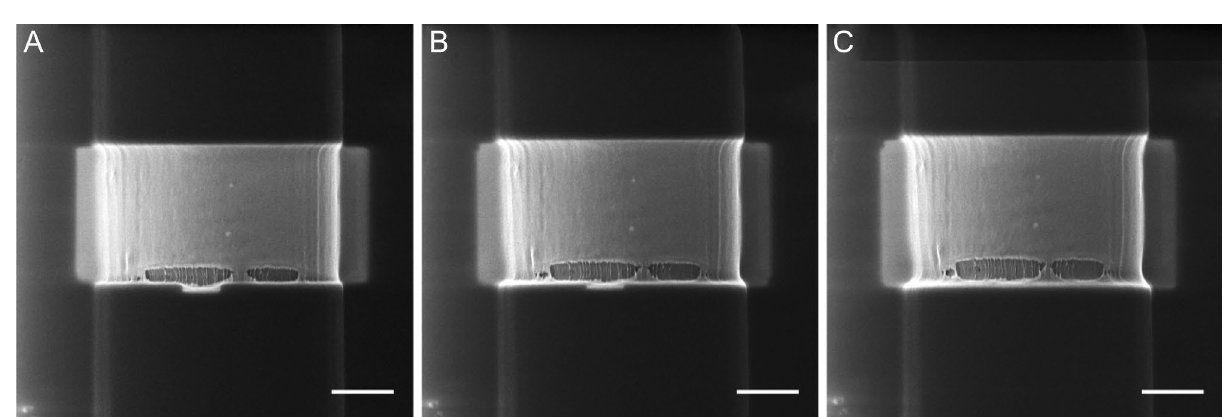
Figure 3. Scanning HIM images of a MiS fibre where the top layers are etched away consecutively by, He ion sputtering. The fibre shown have a diameter of the fibre of 4 µm. VD = 8.5 mm, FoV = 6.5 µm and beam current = 0.284 pA. Scalebar is 1